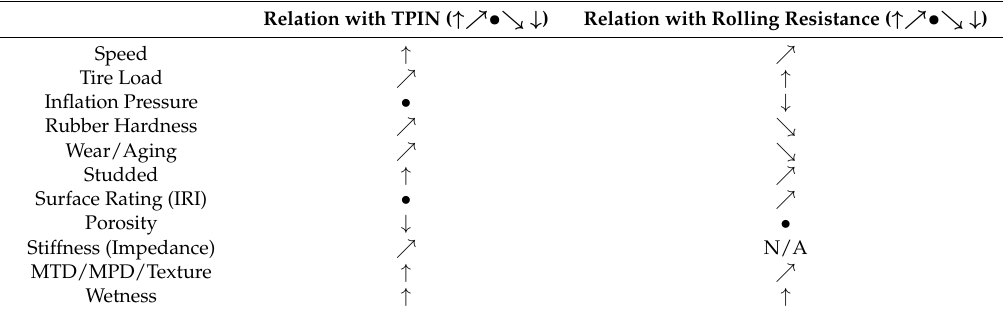
Table 5. General influences of different parameters on TPIN and tire rolling resistance (modified from Ejsmont et al., 2012 [138], Table 1) ( ↑ denotes large increase; (cid:37) denotes small increase; • denotes no influence; (cid:38) denotes small decrease; ↓ denotes large